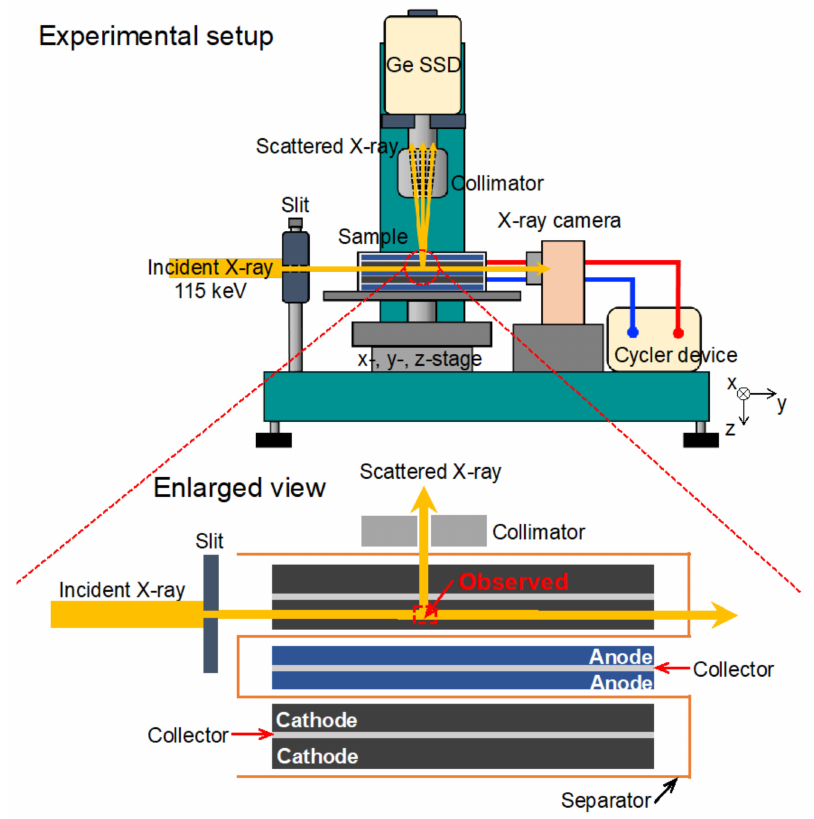
Figure 2. Schematic image of Compton scattering measurement system at BL08W of SPring − 8. The enlarged view shows the detail of the observation area inside a capacitor